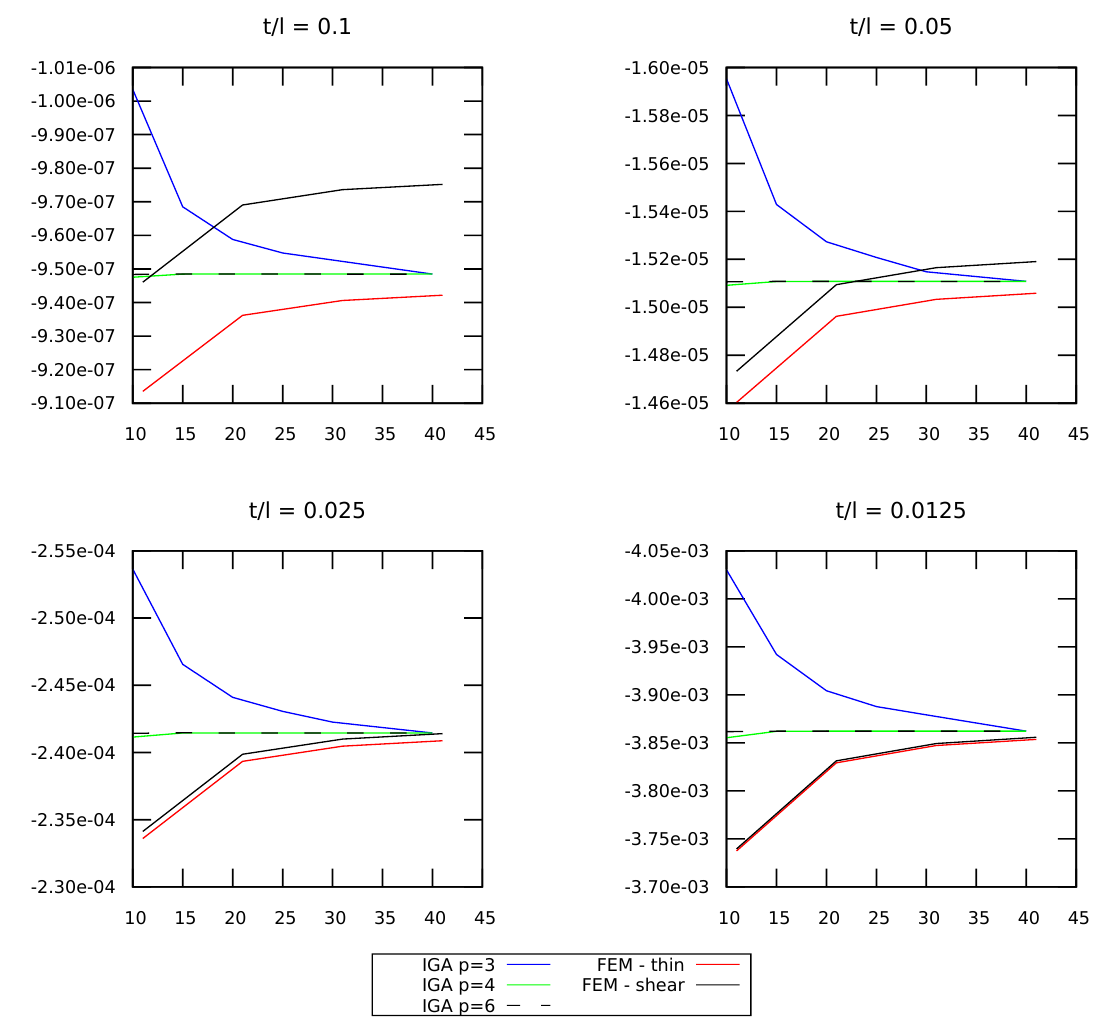
Figure 6. Comparison of isogeometric beam element with cubic (IGA p = 3), quartic (IGA p = 4) and hexic (IGA p = 6) approximation with standard FEM straight beam element with Bernoulli assumptions (FEM - thin) and with account for shear effects (FEM - shear). The vertical axis corresponds to the vertical tip displacement w , the horizontal axis corresponds to the number of nodes (control